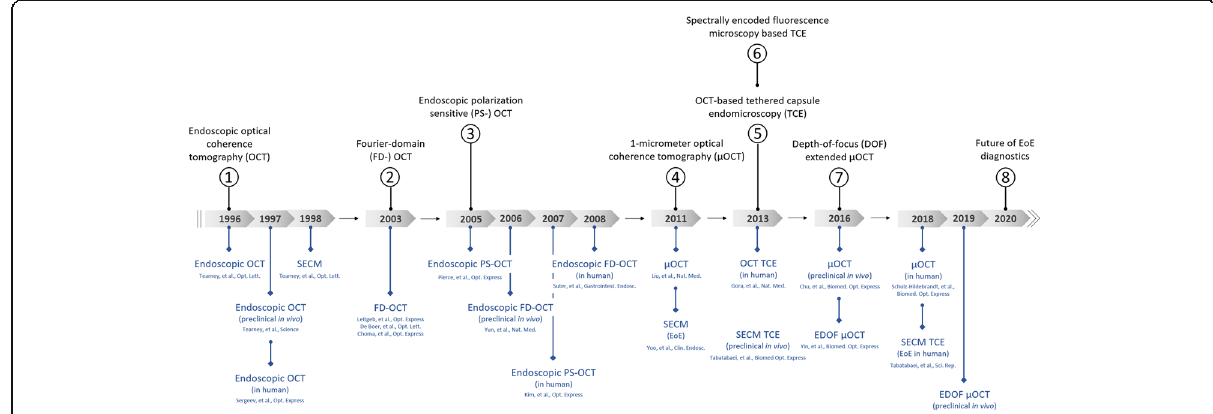
Fig. 2 Key scientific, engineering, and clinical achievements throughout two decades of translational research. The eight milestones are indicated above the timeline in black. Below the timeline, the most fundamental literature reports (divided into first demonstration, first preclinical in vivo , and first-in-human) are listed in